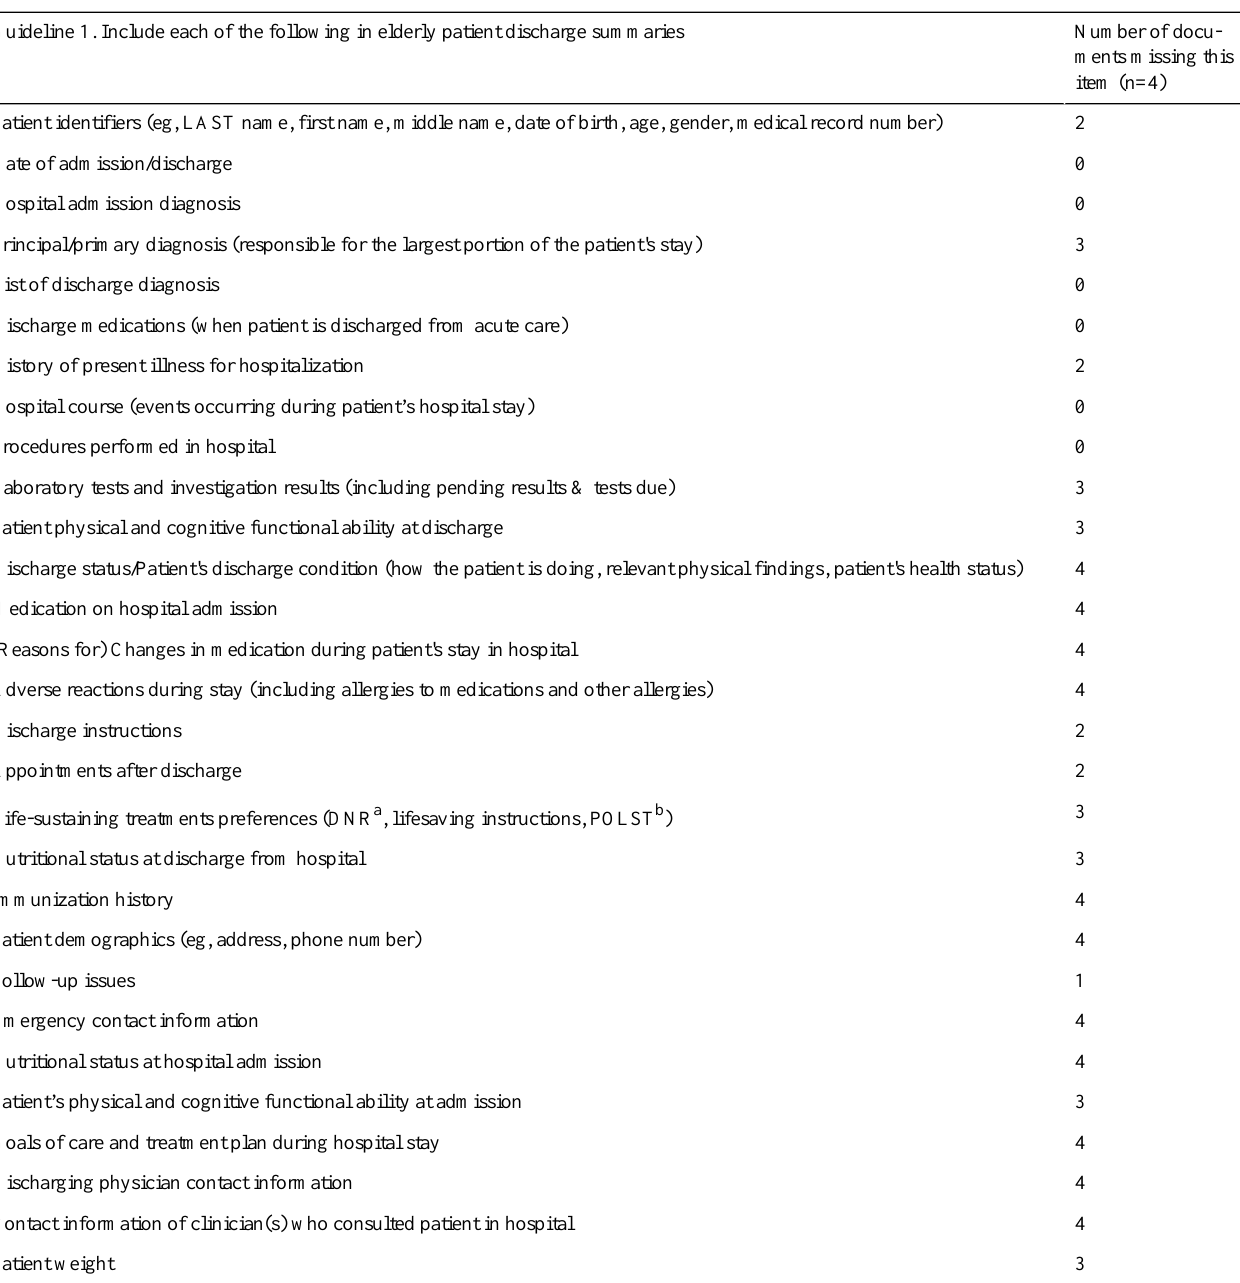
Table 2. First new guideline, with the list of items that should be included in elderly patient discharge summaries and how many of the 4 simulated discharge summaries were missing each